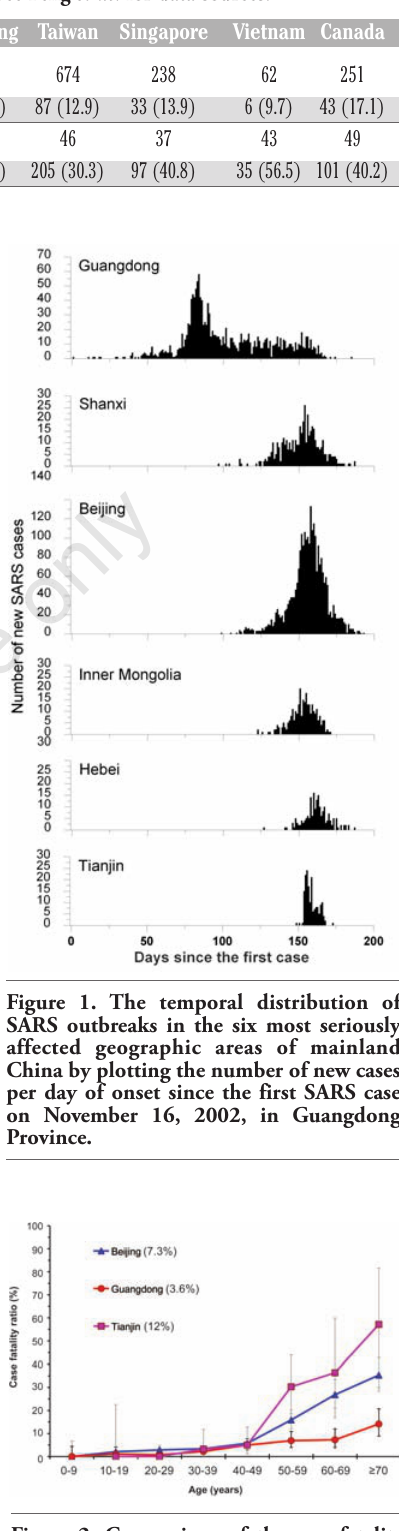
Table 1. The characteristics of the SARS outbreak in mainland China and other countries or regions in 2003. Data concern probable cases. See Feng et al . for data sources.